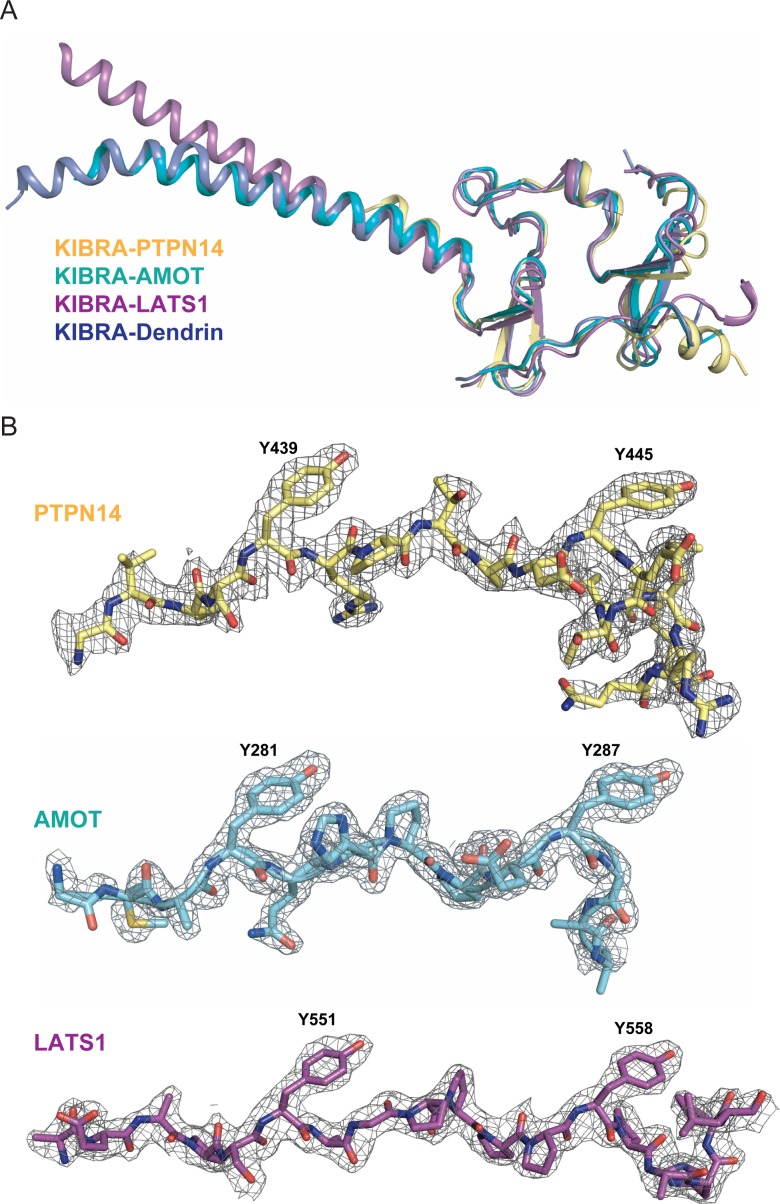
Structures of KIBRA WW12 in Complex with various closely connected PY motifs.(A) Superimposition of the overall structures of the KIBRA WW tandem in complex with PY motifs from PTPN14, AMOT, LATS1, and Dendrin. (B) The electron density maps of PY motifs from PTPN14, AMOT and LATS1 are shown and are colored grey and contoured at 1.5δ.